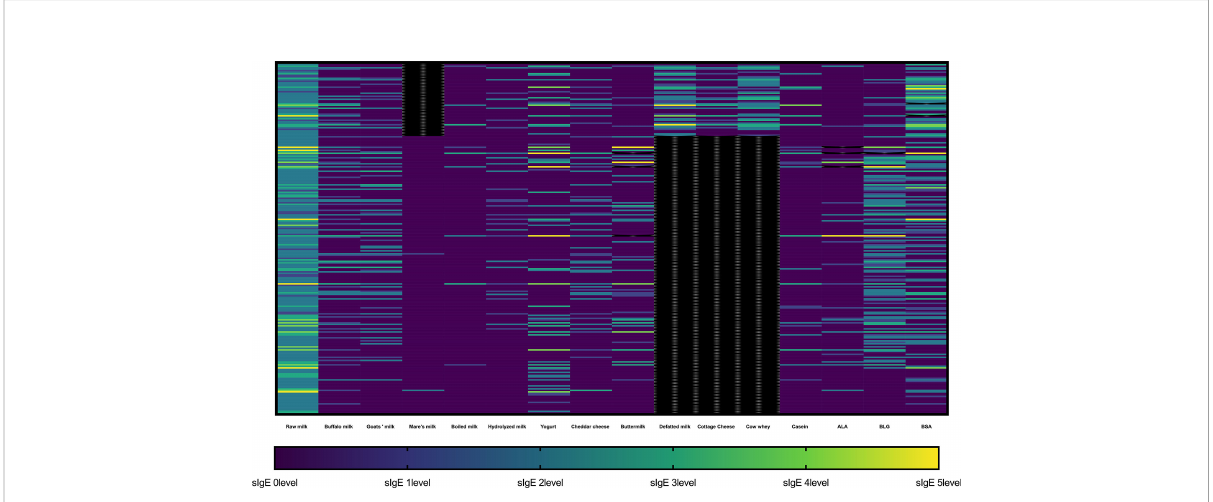
FIGURE 1 Heatmap representing sIgE levels against different milk-related product in each participant. The sIgE result was divided into 6 levels: level 0 (< 0.35 kU/L), level 1 ( ≥ 0.35 kU/L and < 0.7 kU/L), level 2 ( ≥ 0.7 kU/L and < 3.5 kU/L), level 3 ( ≥ 3.5 kU/L and < 17.5 kU/L), level 4 ( ≥ 17.5 kU/L and < 50 kU/L), level 5 ( ≥ 50 kU/L and < 100 kU/L), and level 6 ( ≥ 100 kU/L). The black color represents missing data. ALA, a -lactalbumin; BLG, b - lactoglobulin (BLG); BSA, bovine serum albumin (BSA).